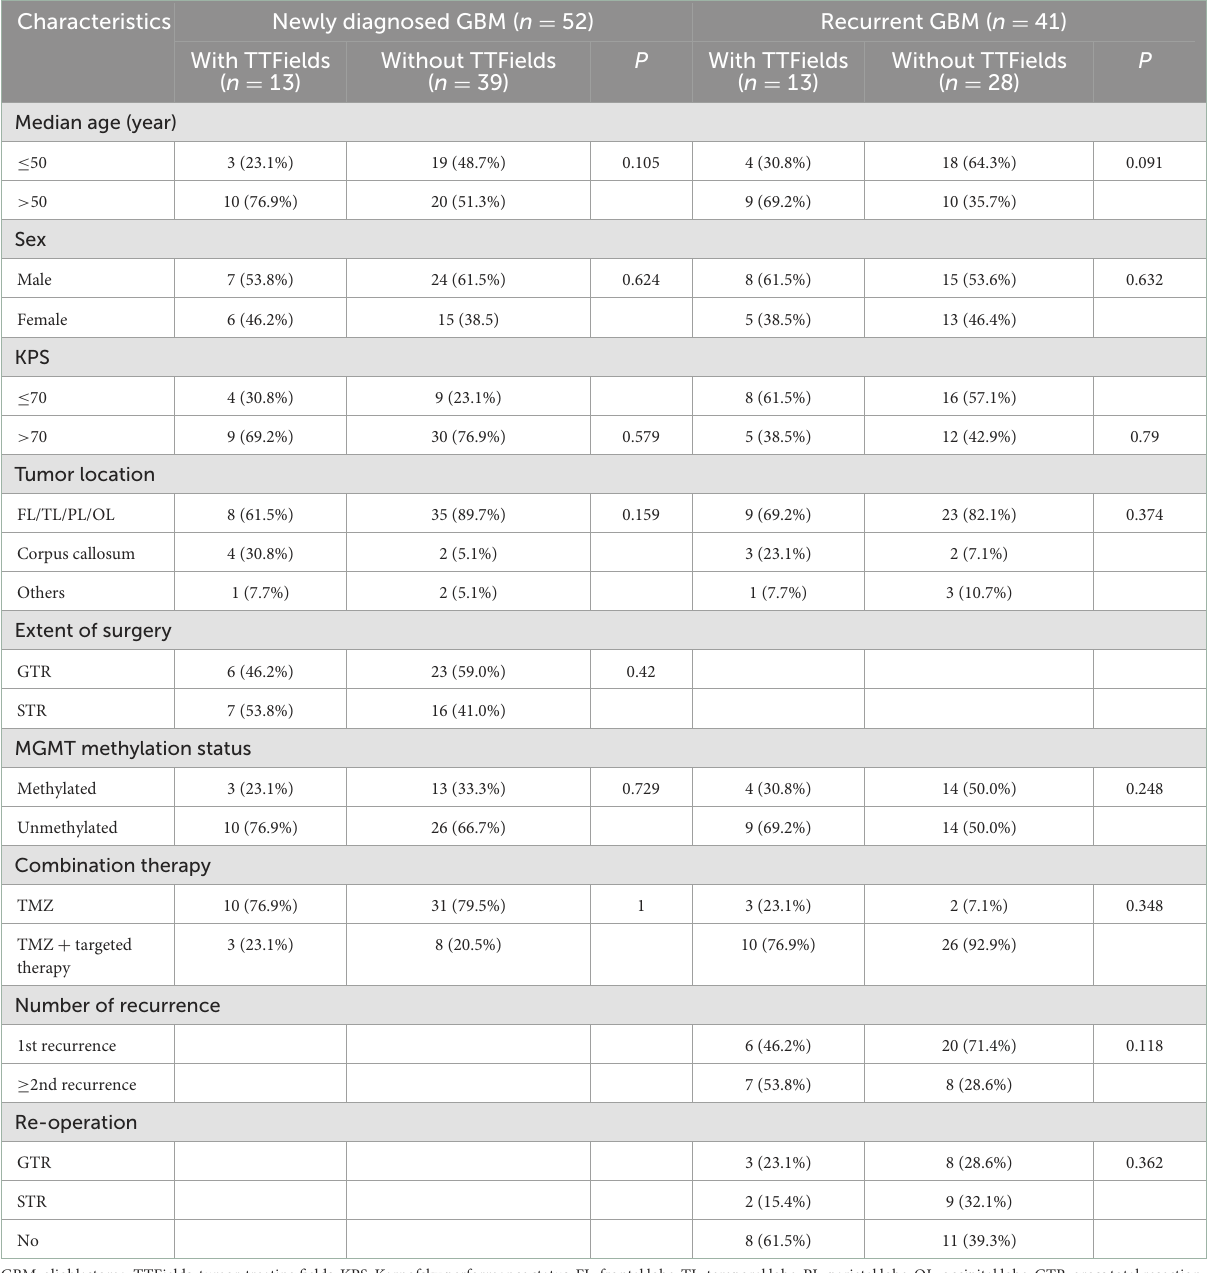
TABLE 1 Clinical characteristics of GBM patients.